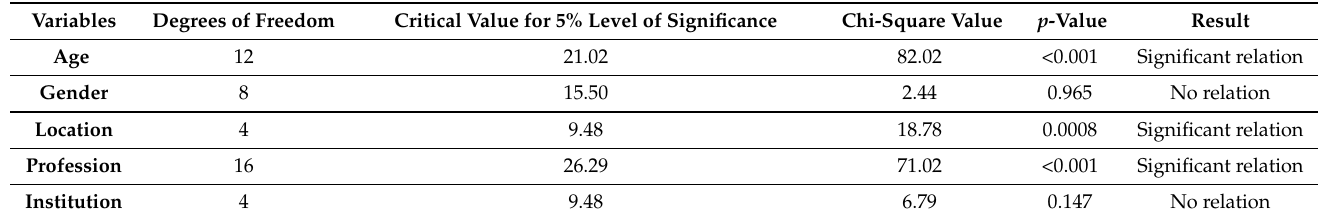
Table 2. The influence of different variables on technical competency related to digital health.